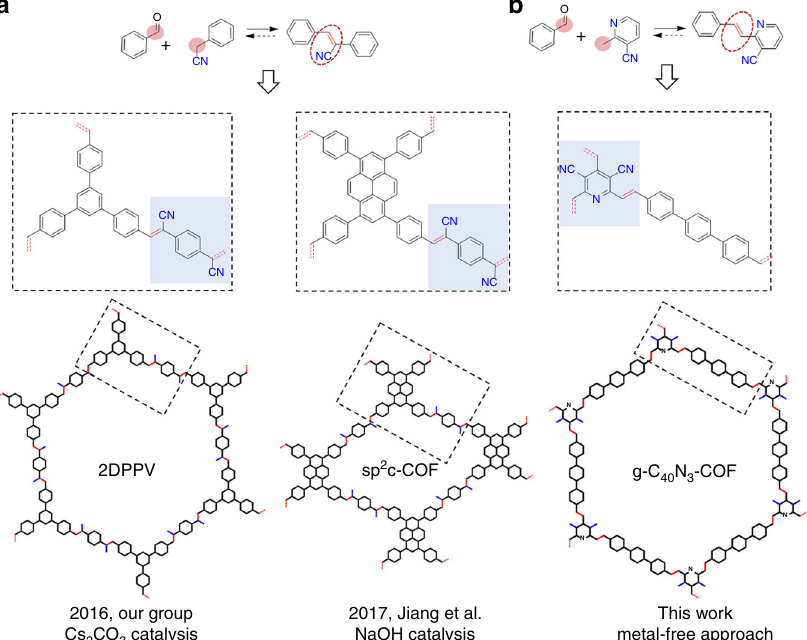
Fig. 1 Chemical structures of the C = C bond linked covalent organic frameworks. a Representative two examples of 2D covalent organic frameworks with carbon – carbon double bond (C = C) linkages through Knoevenagel condensation at methylene carbon atoms by using inorganic base catalysts. b Metal- free approach to the target 2D covalent organic framework (g – C 40 N 3 -COF) with C = C linkages via condensation at arylmethyl carbon atoms upon organic base